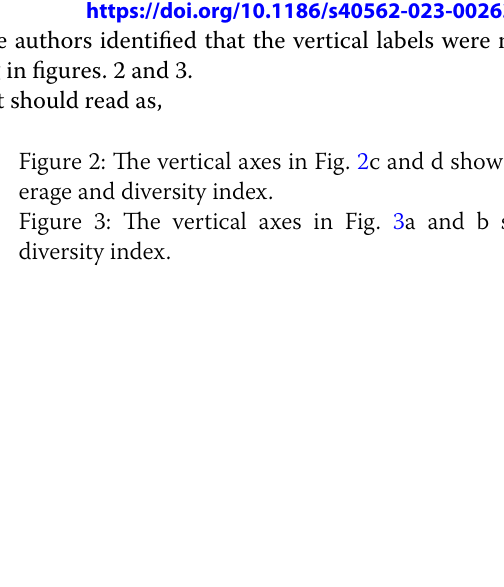
Figure 2: The vertical axes in Fig. 2c and d show cov- erage and diversity index. Figure 3: The vertical axes in Fig. 3a and b show diversity